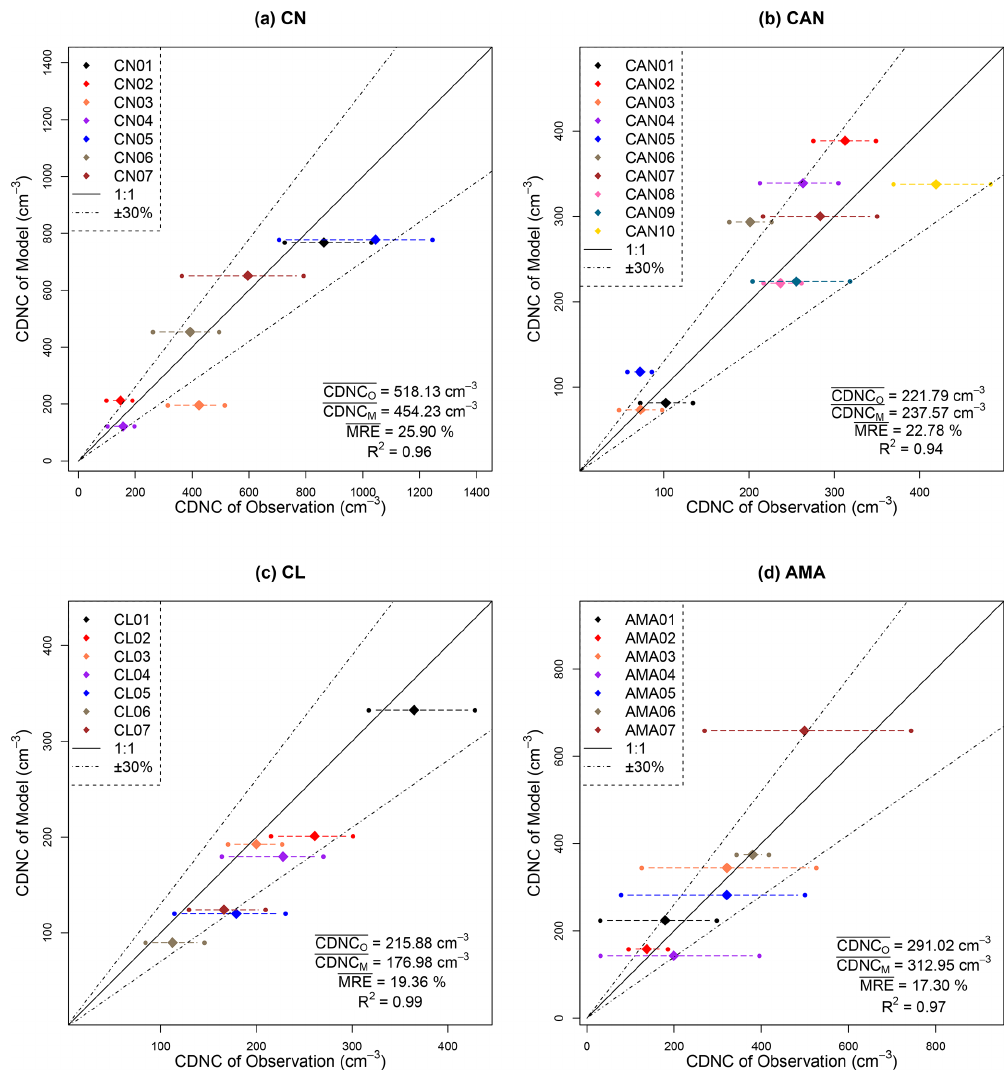
Figure 9. A closure experiment between CDNC O and CDNC M for each cloud case in the (a) CN, (b) CAN, (c) CL, and (d) AMA campaigns. The horizontal dashed lines represent the range of the observed CDNC within the 25% and 75%